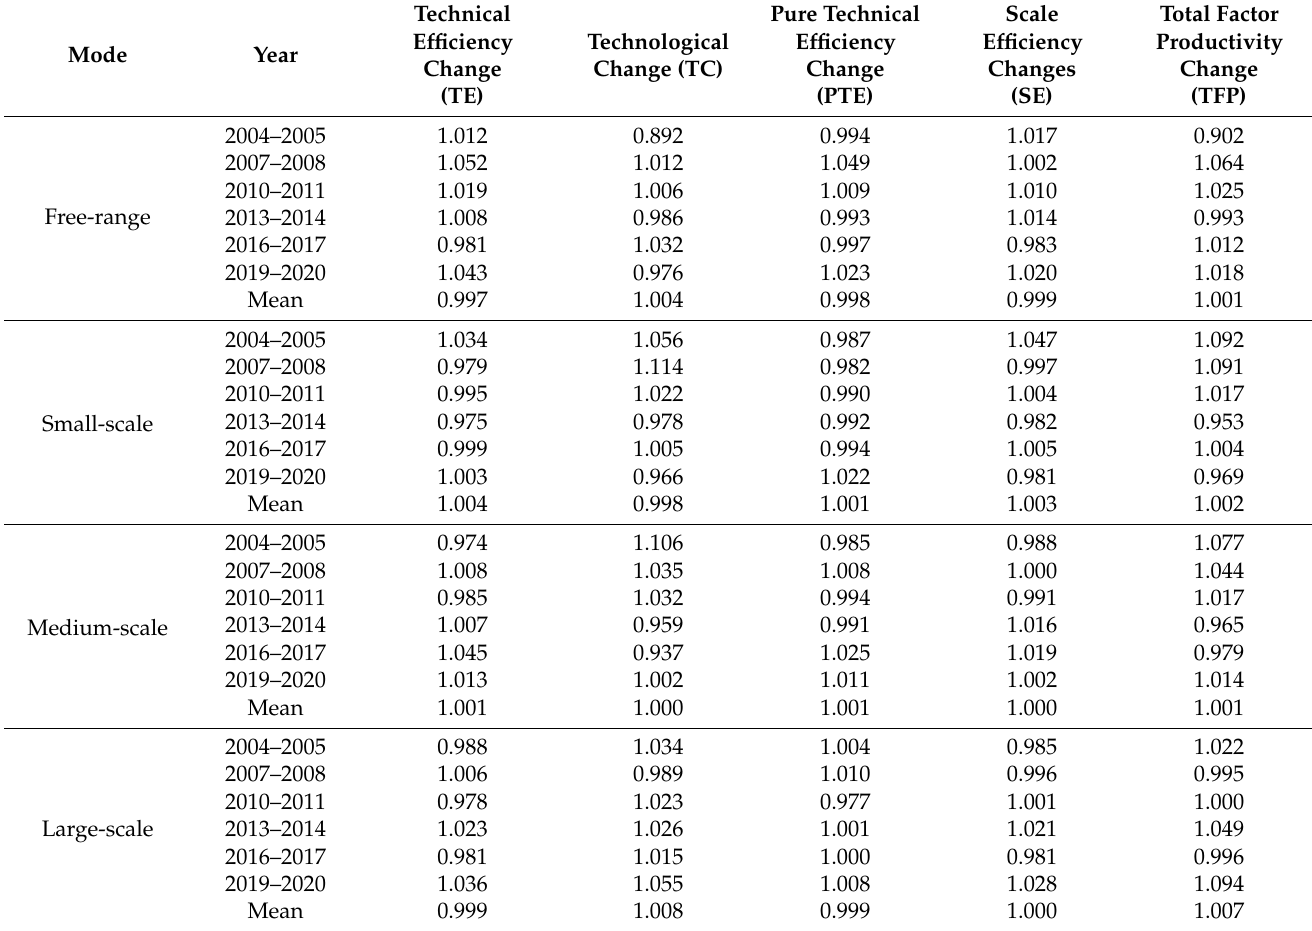
Table 1. Changes in TFP and its composition of raw milk from 2004 to